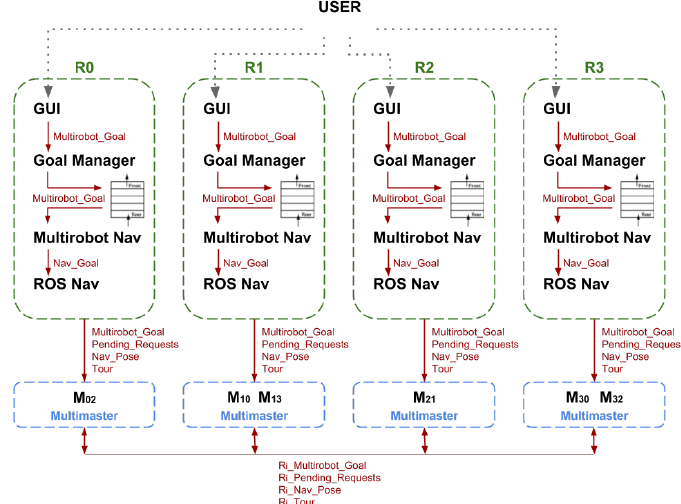
Figure 3. Multi-robot system architecture. M ij denotes that the multi-master facilitates communication between masters i and j , i.e., robots i and j (reproduced with permission from Springer Nature under License Number